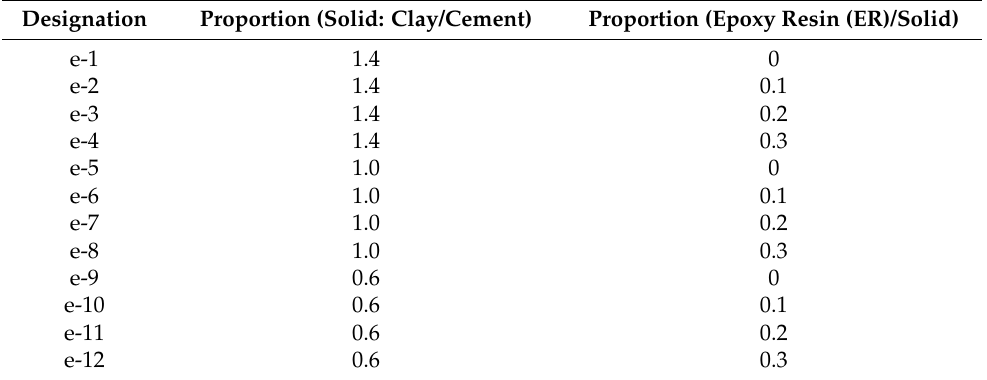
Table 4. Composition of the tested